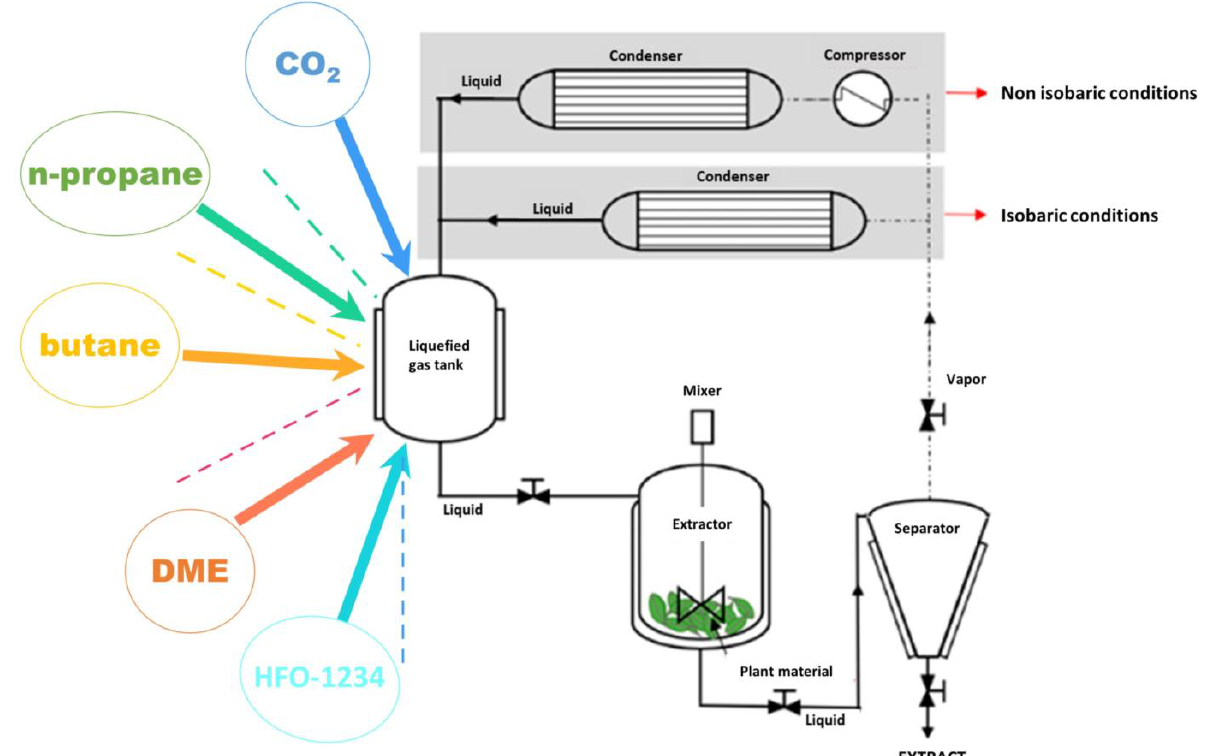
Figure 9. Process diagram of a unit designed for extraction using CO 2 or liquefied gases.